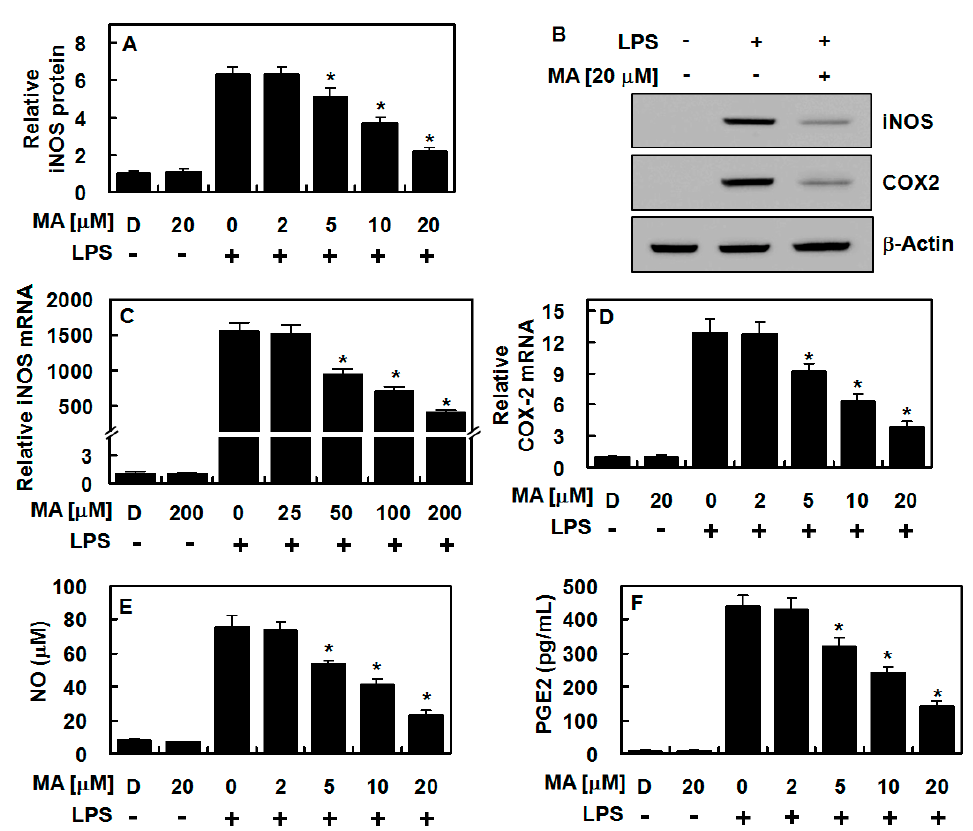
Figure 1. Maslinic acid (MA) suppressed COX-2 and iNOS levels in lipopolysaccharide (LPS)-treated human umbilical vein endothelial cells (HUVECs). After LPS stimulation (1 μ g/mL, 6 h), HUVECs were treated with indicated concentrations of MA for 6 h, and the levels of iNOS protein ( A,B ), COX-2 protein ( B ) (Uncropped pictures of the Western blot was shown in Figure S1), iNOS mRNA ( C ), COX-2 mRNA ( D ), NO ( E ), and PGE2 ( F ) were analyzed. The results represent the mean value with SD from three independent experiments conducted in triplicates on different days. D denotes 0.2% DMSO treatment, which was used as the vehicle control. * p < 0.05 versus LPS.